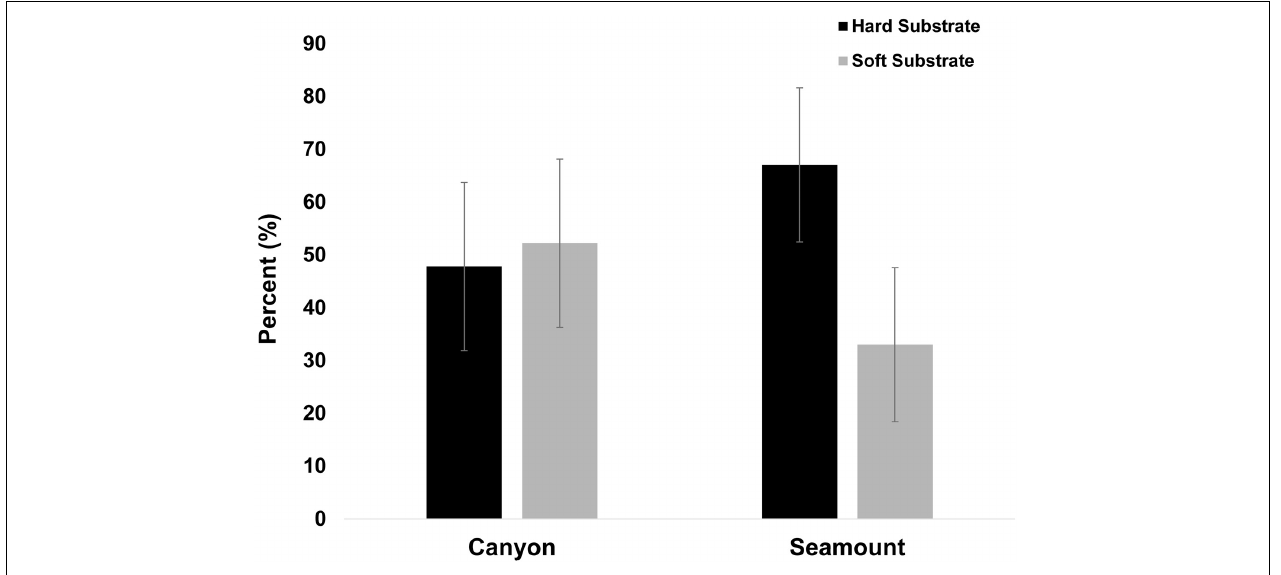
FIGURE 3 | Percent of hard and soft substrates observed in canyons and seamounts ( n = 1,796). Hard substrate was observed more often on seamounts. TABLE 2 | SIMPER (similarity percentage) results showing which taxa made the greatest contribution to the dissimilarity between canyon and seamount communities ( n = 1,105 segments). Average abundance (# 25 m − 2 ) Dissimilarity/SD % Contribution Species Canyons Seamounts Porifera sp. 2